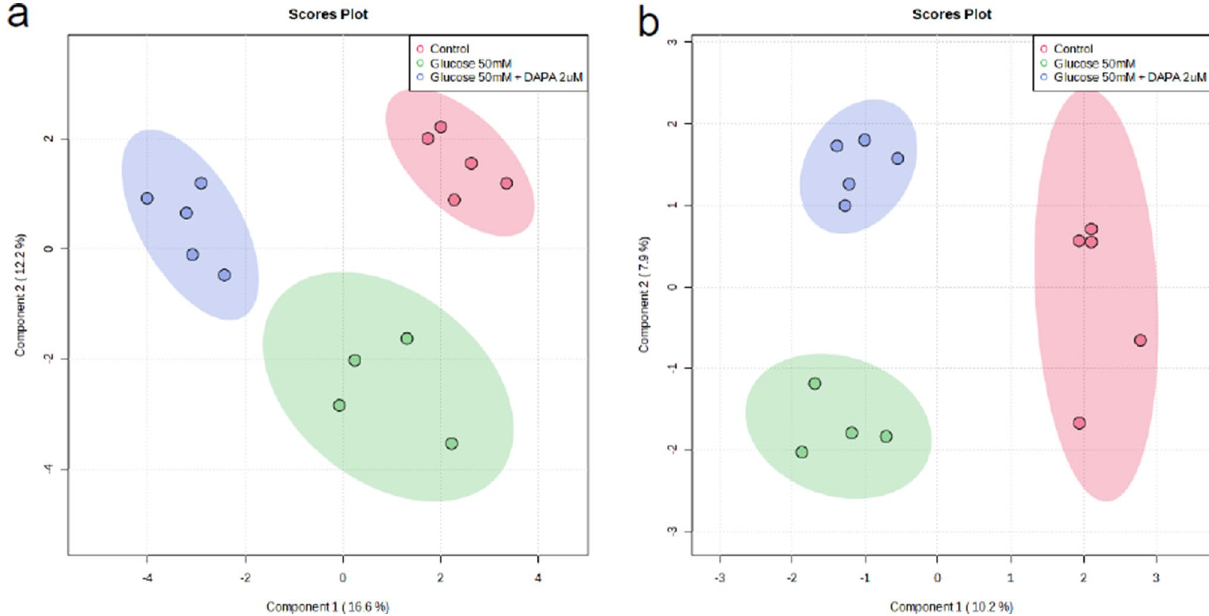
Figure 2. Sparse partial-least-squares discriminant analysis (sPLS-DA) of metabolites detected in tubular epithelial cells ( a ), podocytes ( b ), respectively, treated with 2 µM dapagliflozin following 50 mM glucose compared to those without treatment (control) and compared to those treated with 50 mM glucose. sPLS-DA in 2D scoring plot with 95% confidence